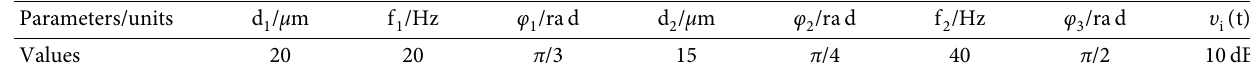
Table 2: Some parameters of the mixed signal in